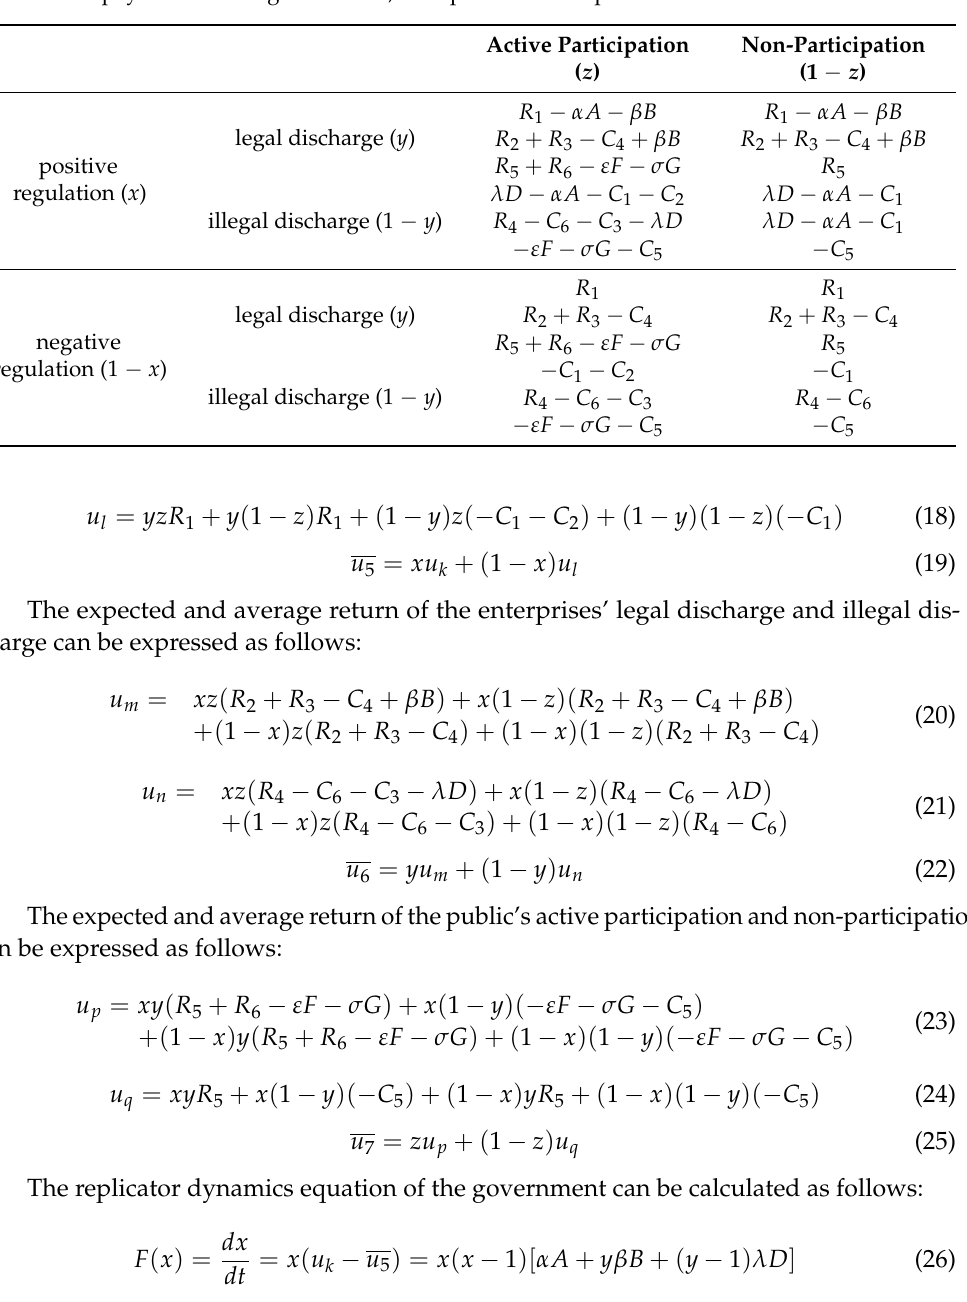
Table 4. The payoff matrix of government, enterprises and the public.